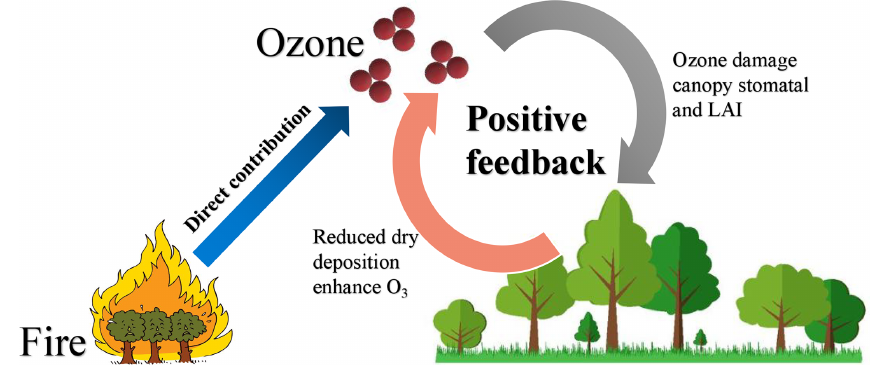
Figure 1. Diagram of the impacts of fires on surface O 3 through direct emissions and O 3 –vegetation feedback.